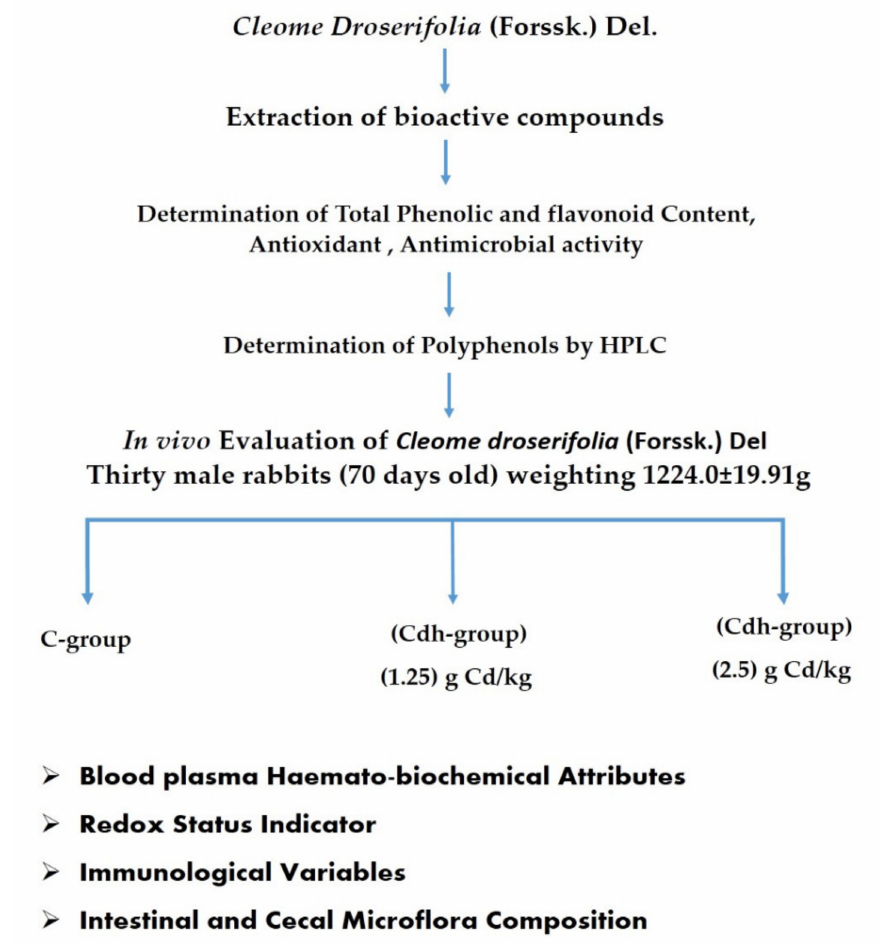
Figure 1. Flow chart of in vitro and in vivo evaluations of Cleome droserifolia (Forssk.)